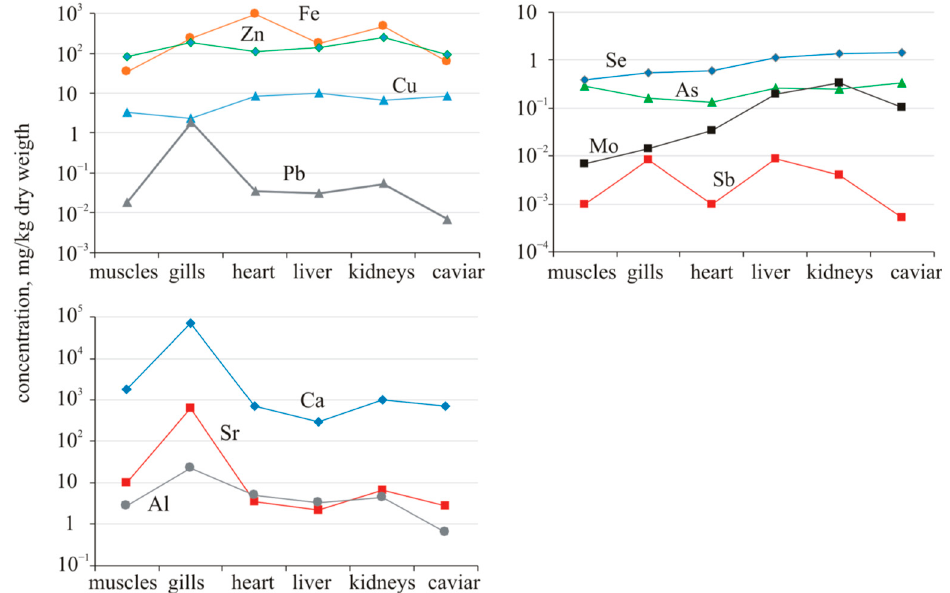
Figure 5. Distribution of elements in organs of Carassius gibelio from Chany Lake (background reservoir).